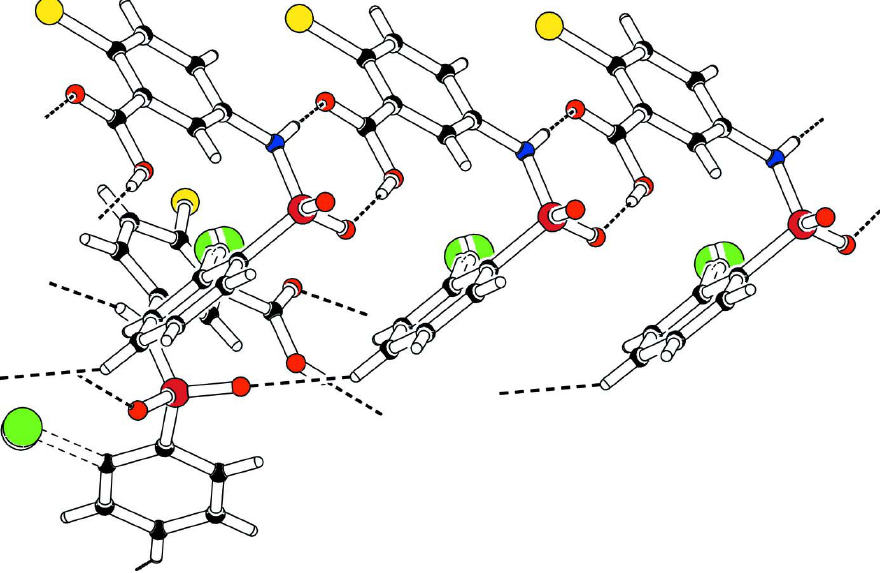
A partial packing diagram of the title compound. Hydrogen bonds are shown as dashed